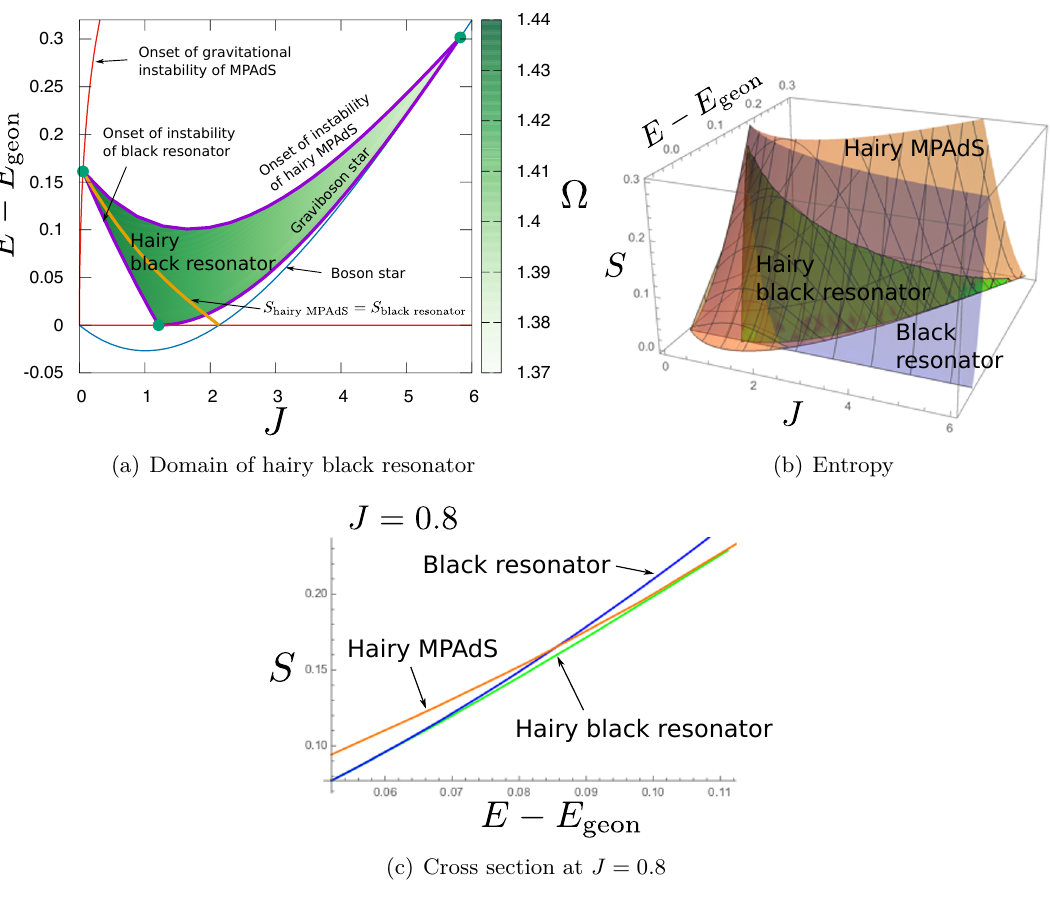
Figure 5 . (a) Domain of existence of the hairy black resonator. It exists inside the “triangle” sur- rounded by purple curves. The equal-entropy-curve between the hairy MPAdS and black resonator is plotted by the orange curve. The angular velocity is shown by the color map. (b) Entropies of the black resonator (blue), hairy MPAdS (orange), and hairy black resonator (green) for j = 9 / 2 . The entropy of the hairy black resonator is never the largest. (c) Cross section of (a) at J = 0 . 8